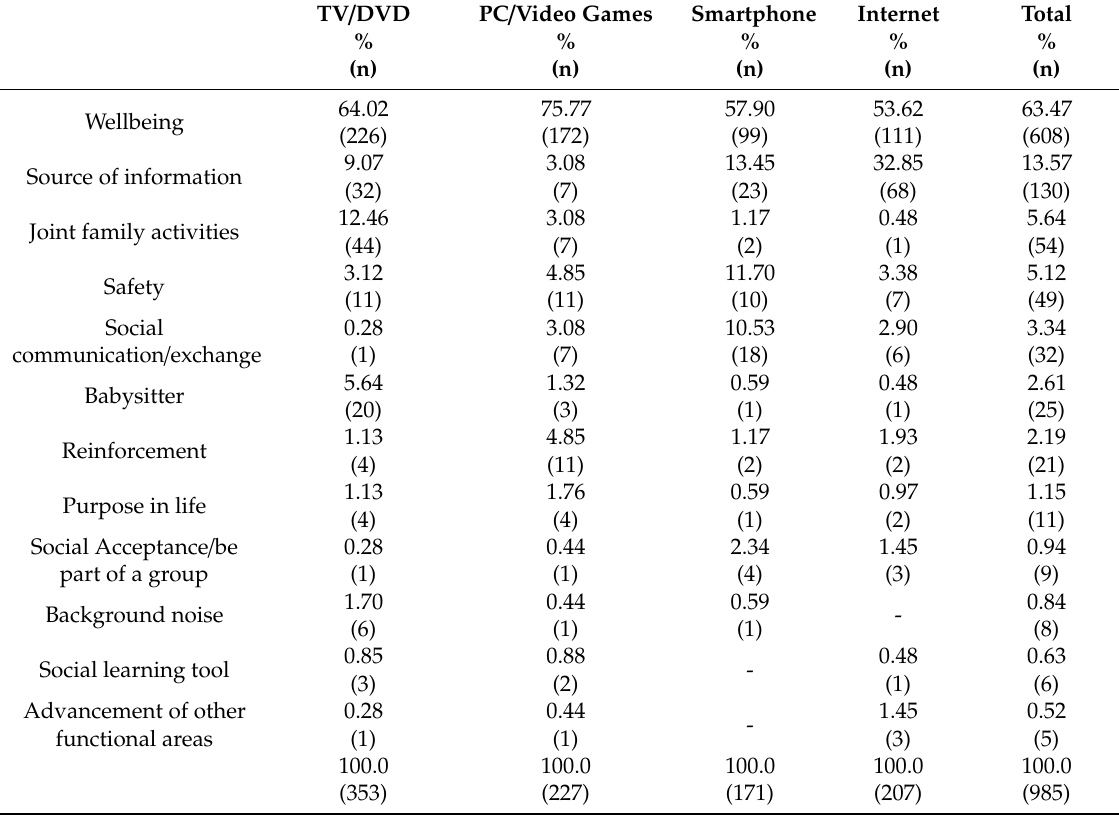
Table 5. Codes and their frequency of